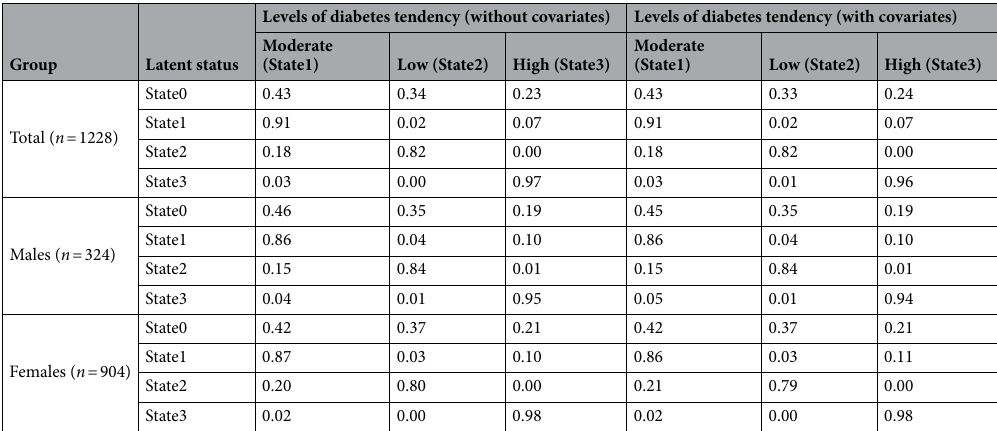
Table 4. Initial and transition’s probabilities of prediabetic subjects resulted from latent Markov analysis. The state0 is initial state. Probabilities represent the probability of transition from a particular state to other states from row to